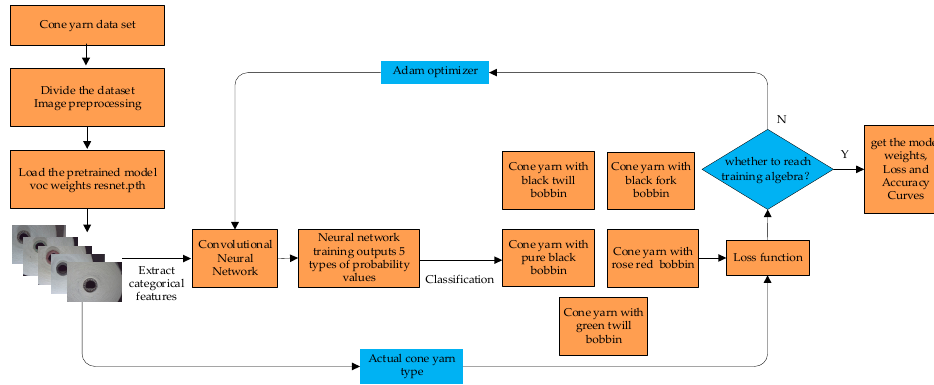
Figure 9. Model training process.